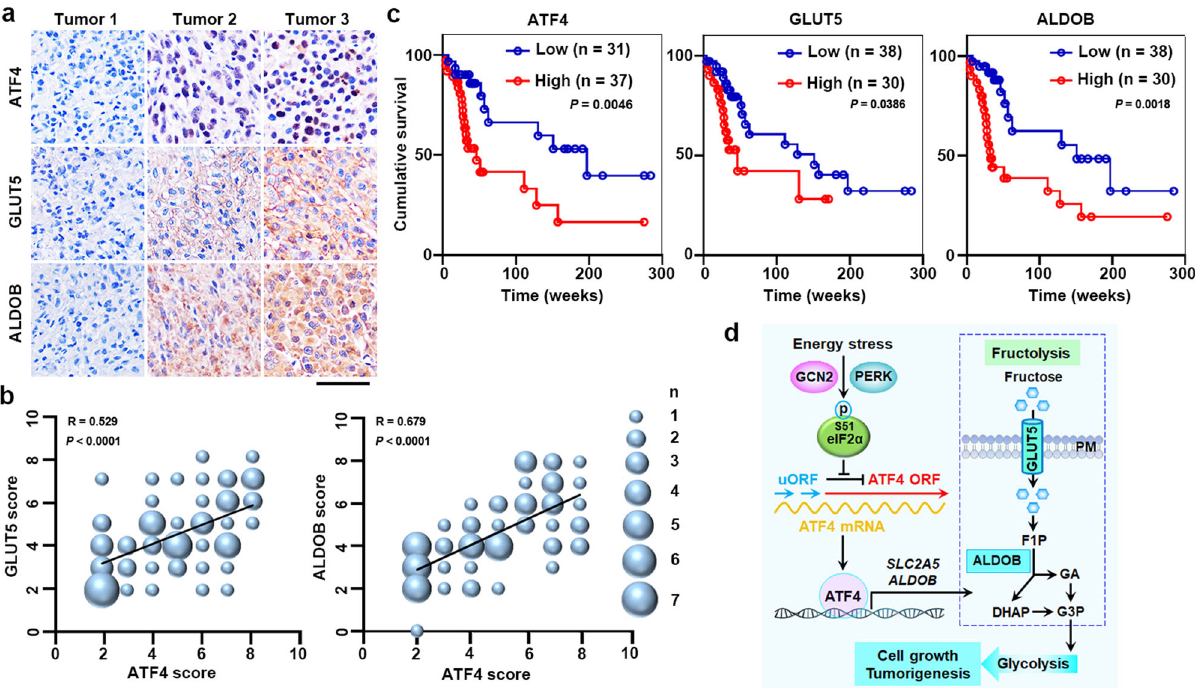
Fig. 6 | The expression levels of ATF4, GLUT5, and ALDOB positively correlate with each other in GBM specimens and indicate a poor prognosis in GBM patients. a , b Sixty-eight human primary GBM specimens were immunohisto- chemically stainedwith indicatedantibodies. Representative photos oftumorsare shown ( a ). Immunohistochemistry staining scores of ATF4, GLUT5, and ALDOB wereanalyzedbySpearman ’ scorrelation( b ).Notethatsize(rangingfrom1to7)of thedotsrepresentsthenumberofspecimen(s)appearingonthegraphs.Scalebar, 50 µ m ( a ). c The survival time for 68 patients with low (1 – 4 staining scores, blue curve) versus high (5 – 8 staining scores, red curve) levels of ATF4, GLUT5, and